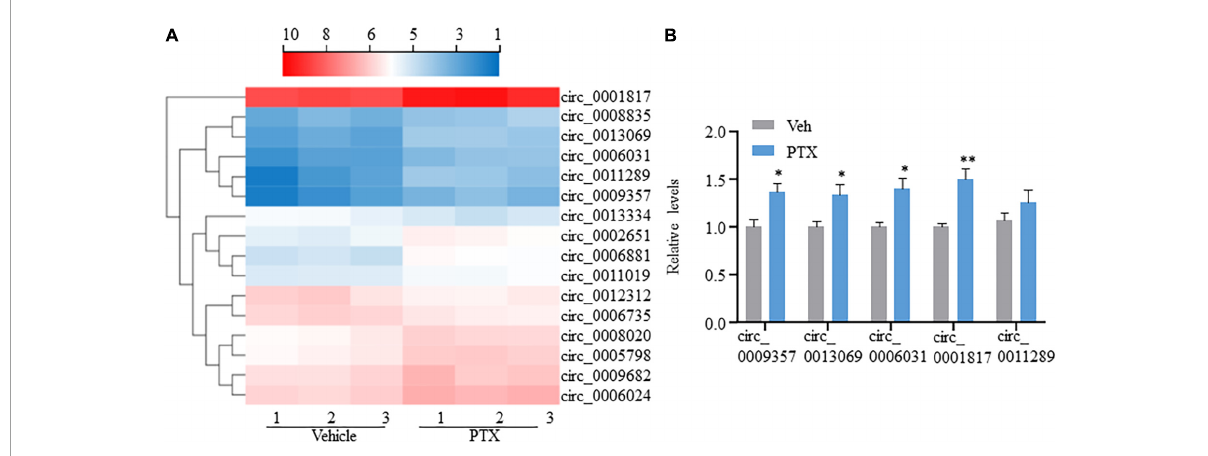
FIGURE3 Transcriptome profiling and validation of circRNA expression in paclitaxel (PTX)-treated mice. (A) Hierarchical clustering analysis shows 16 differentially expressed circRNAs in vehicle and PTX groups. (B) Validation of differentially expressed circRNAs using quantitative polymerase chain reaction. Results are presented as mean ± SEM of 4–5 independent experiments. ∗ P < 0.05; ∗∗ P < 0.01 compared with vehicle group by two-tailed unpaired t